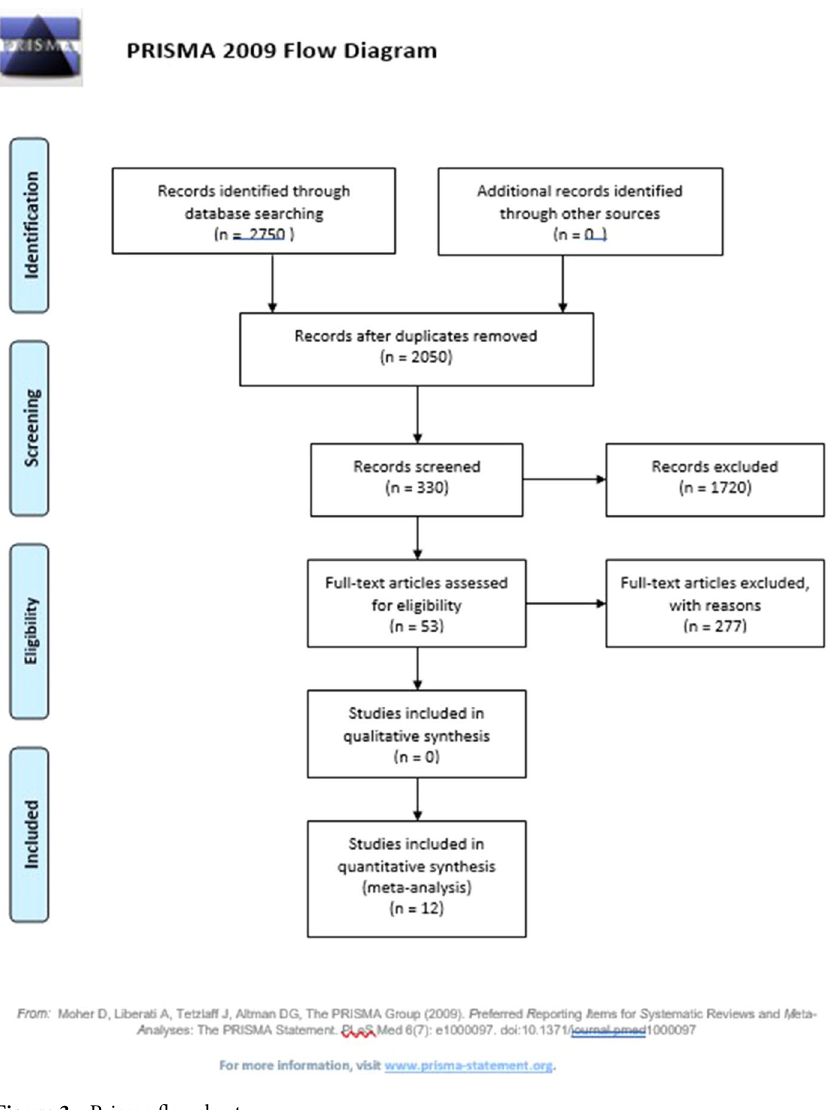
Figure 3. Prisma